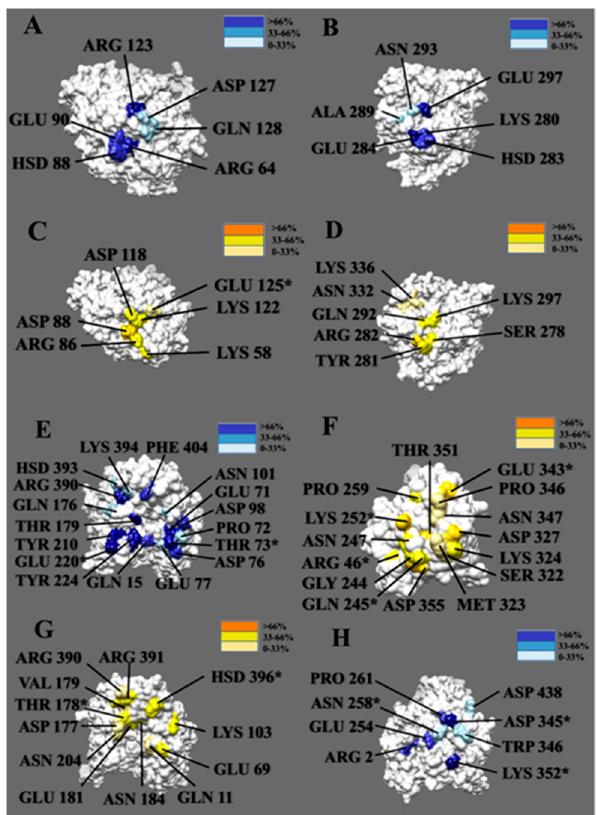
Figure 8. Residue distribution across the binding interfaces of tubulin subunits is color-coded based on the occupancy percentage. ( A , B ) Residues forming salt bridges at the interface of the α / α tubulin complex. ( C , D ) Residues forming salt bridges at the interface of the β / β tubulin complex. ( E , F ) Residues forming salt bridges at the interface of the α / β tubulin complex. The left is α tubulin while the right is β tubulin. ( G , H ) Residues forming salt bridges at the interface of β / α tubulin complex. The left is β tubulin while the right is α tubulin. (* indicates residues with more than one salt bridge